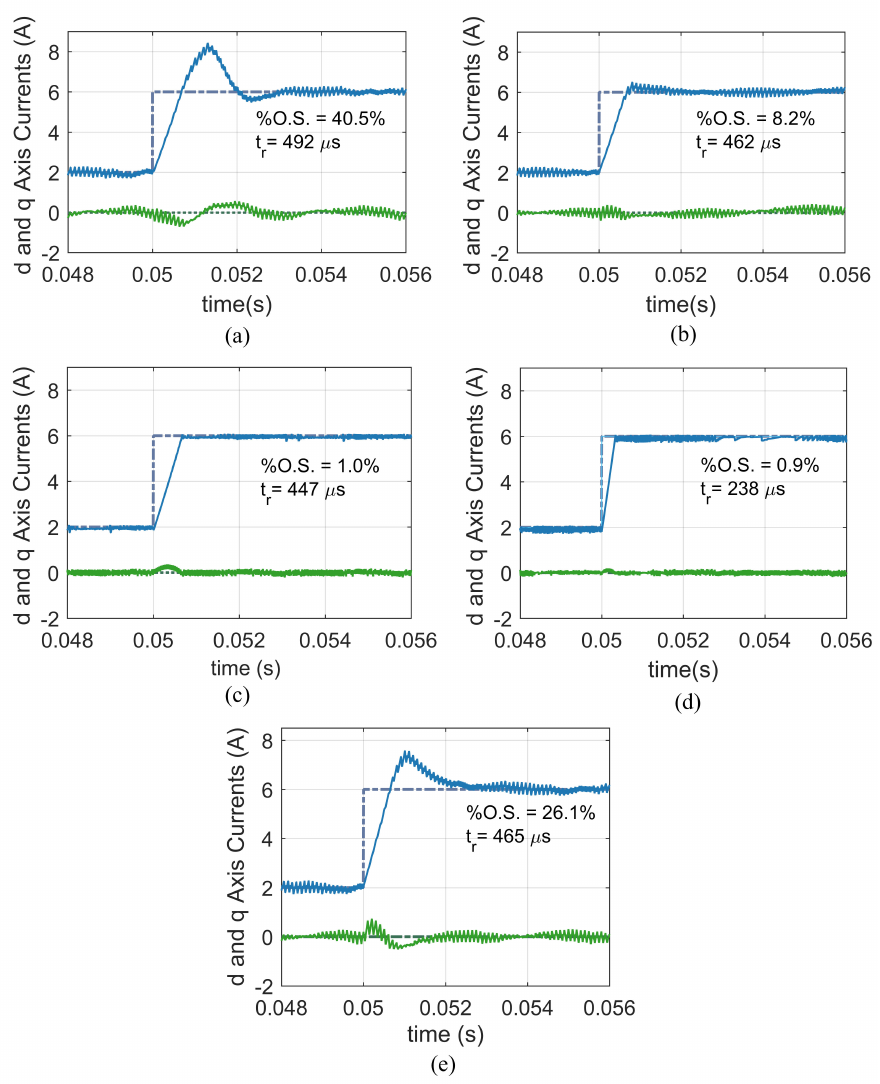
Figure 13. Comparison of d -axis and q -axis current responses. ( a ) PI controller. ( b ) PR controller. ( c ) Hysteresis controller. ( d ) MPC. ( e ) Supplementary ADP controller; O.S.: